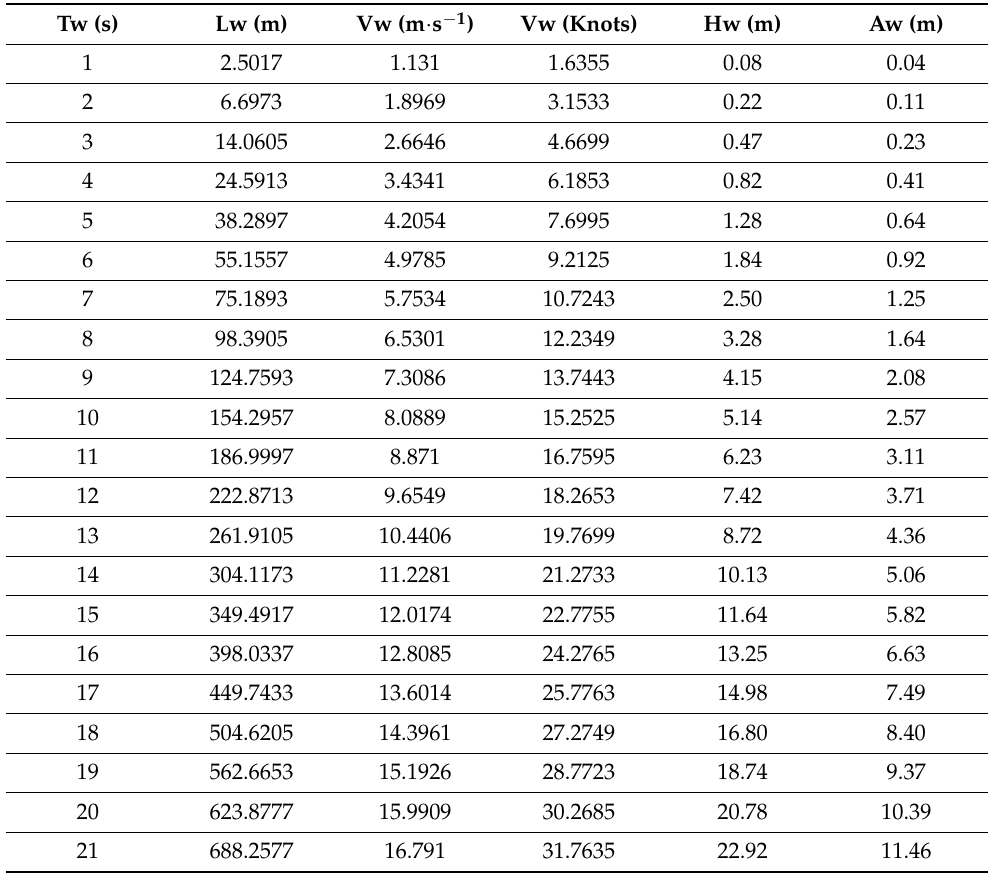
Table 1. Parameters of regular waves’ full